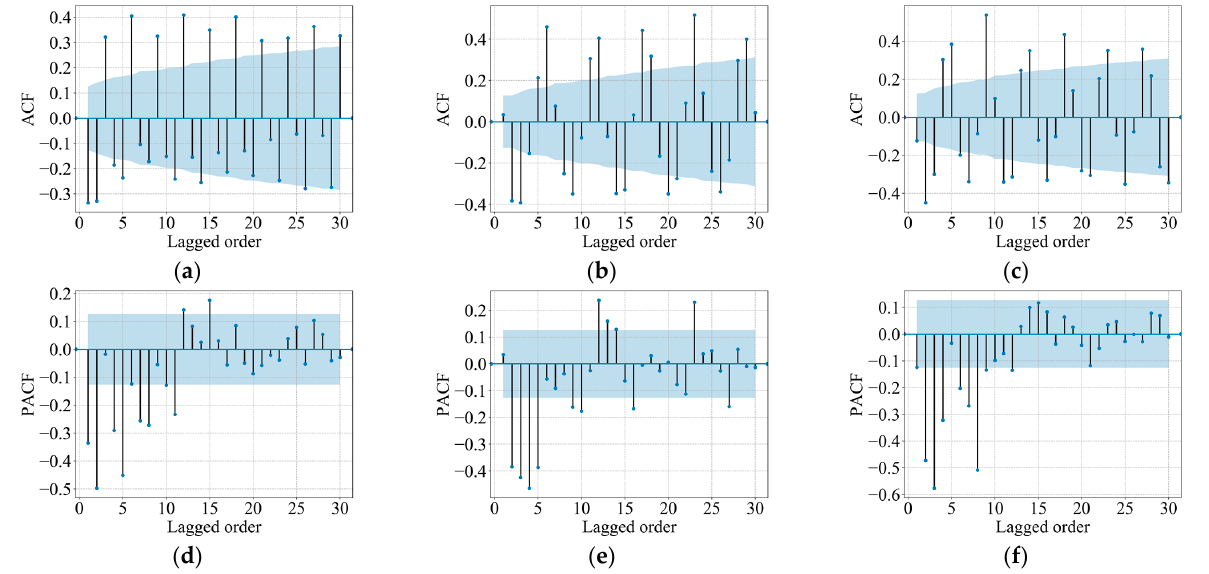
Figure 6. ADF test results.